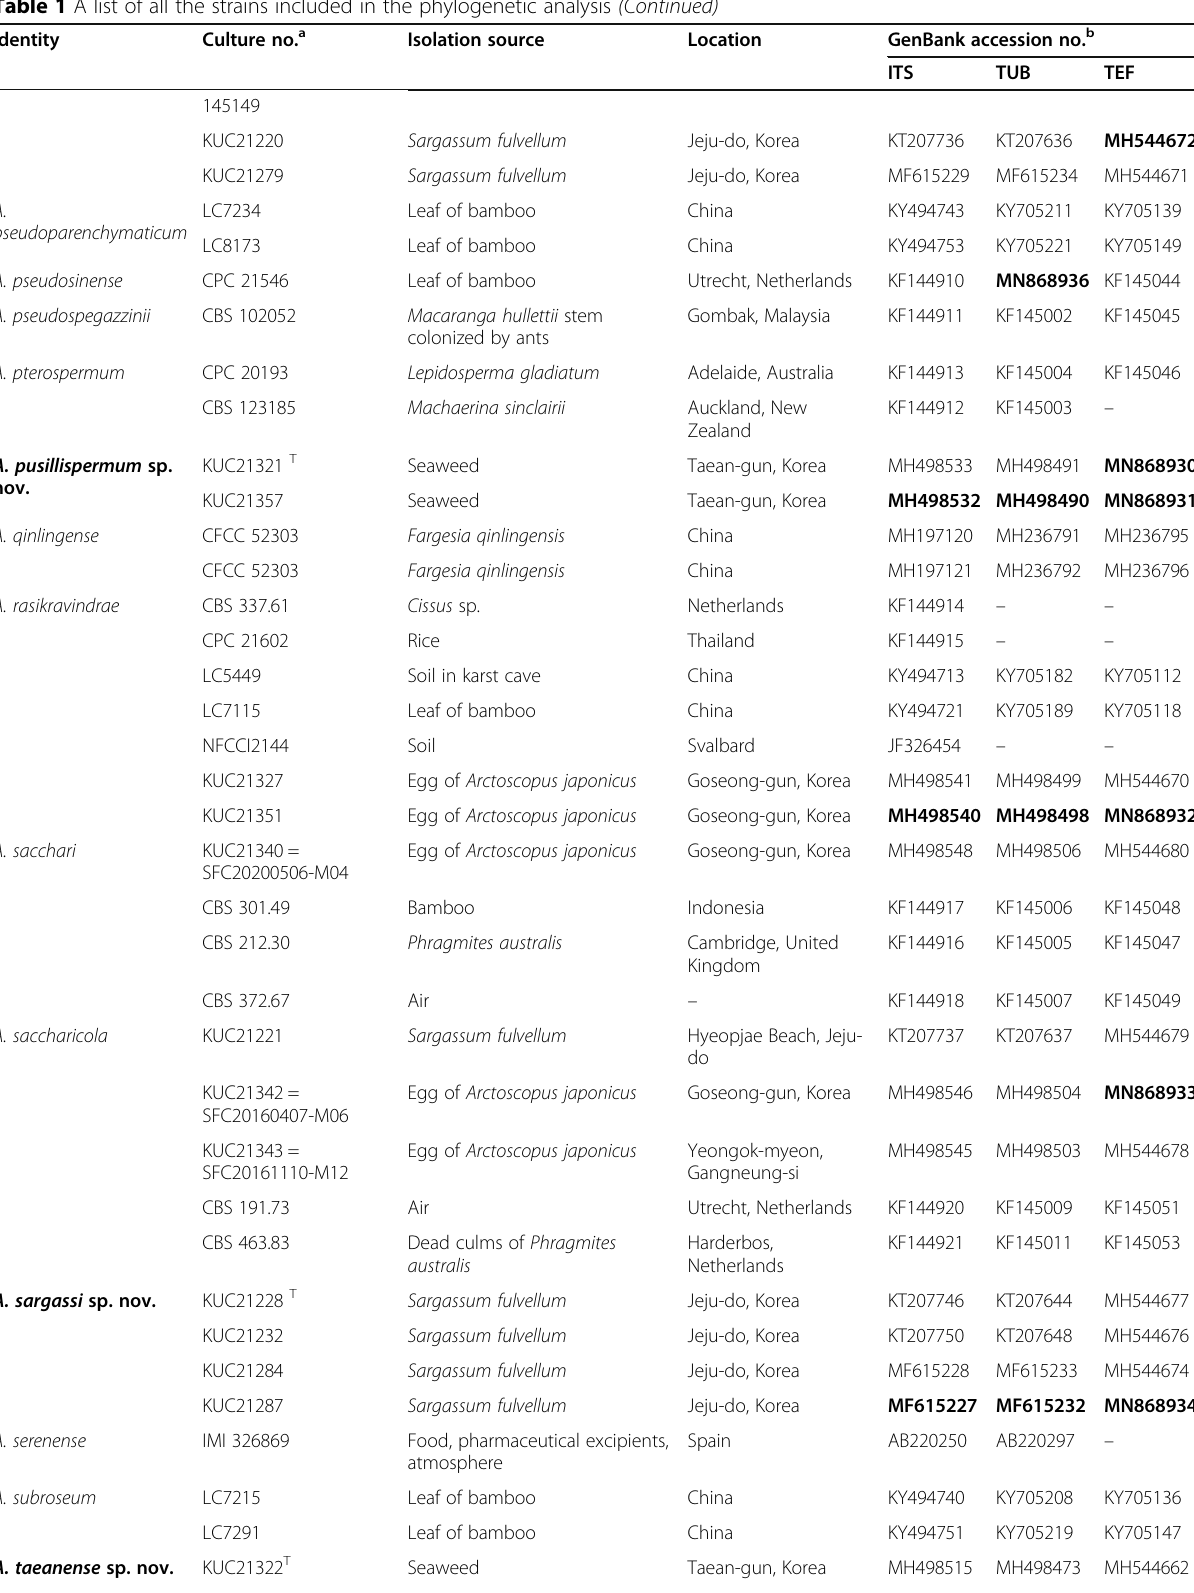
Table 1 A list of all the strains included in the phylogenetic analysis (Continued)